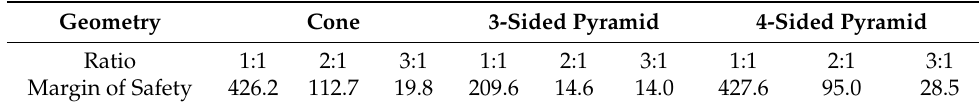
Table 3. Obtained values for MNs’ margin of